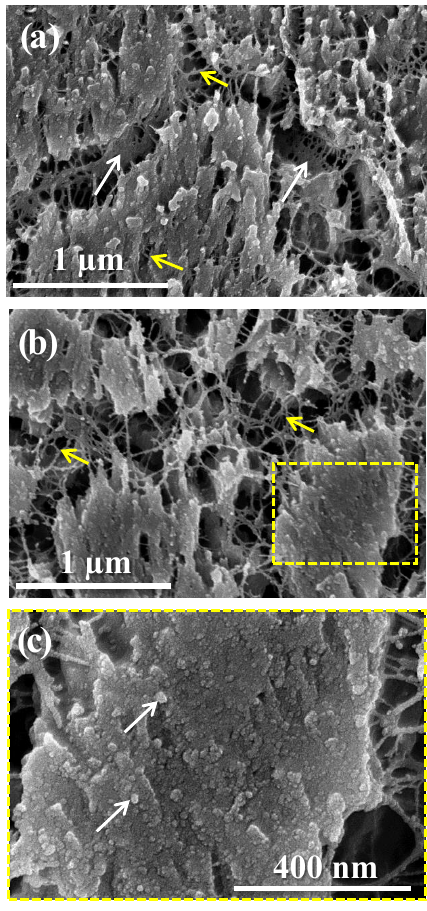
Figure 3. FE-SEM micrographs of cut, microtome-polished, etched, and critical-point-dried surfaces of modern Arctica is- landica next to seawater (a) and close to the soft tissue of the ani- mal (b, c) . Etching occurred for 180s and slightly removed arago- nite in order to visualise the spatial distribution of (glutaraldehyde- stabilised) biopolymers within the shell. Readily visible are the nano-particulate consistency of the aragonitic hard tissue (white ar- rows in c ) and the presence of biopolymer membranes (white ar- rows in a ) and fibrils (yellow arrows in a , b ) between and within the mineral